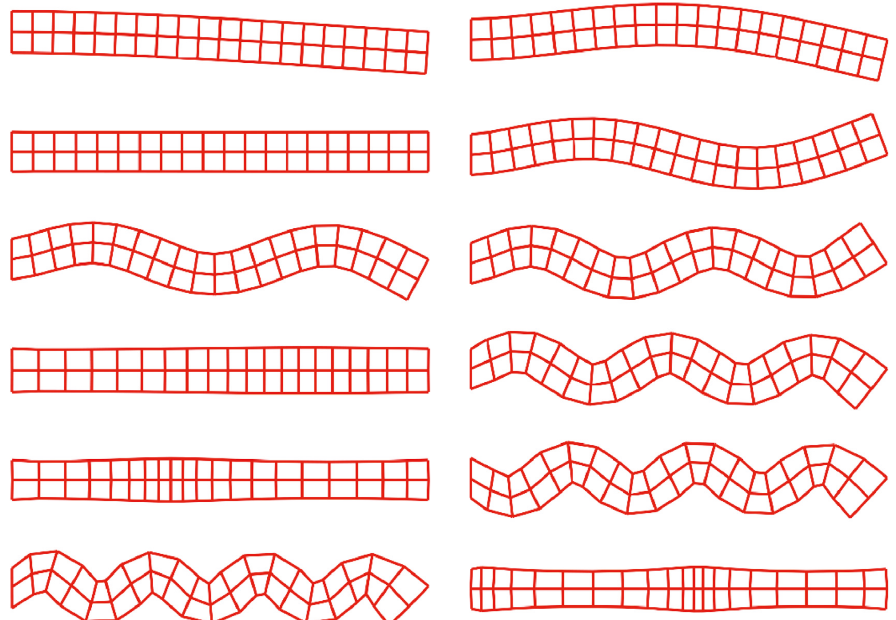
Figure 16: First 12 modeshapes of cantilever